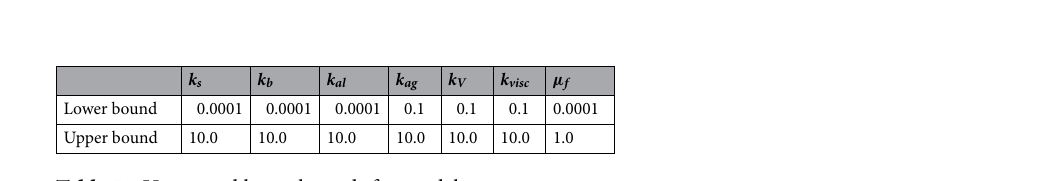
Table 5. Upper and lower bounds for model